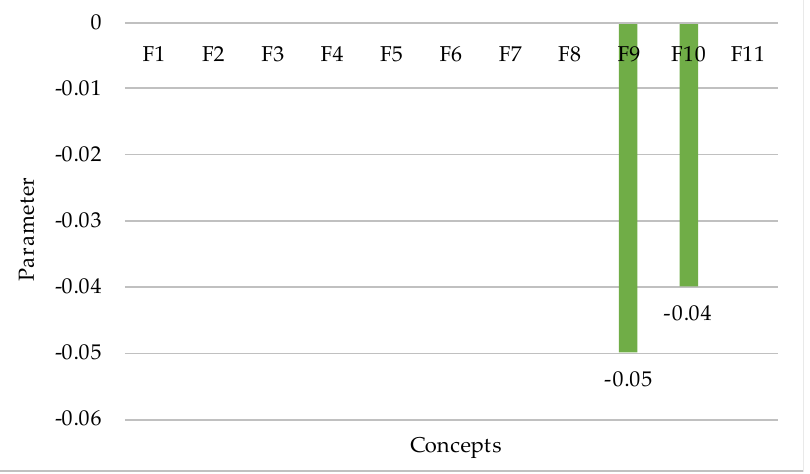
Figure 2. Scenario demonstrating the system response to the most negative changes in the concept 3F —malware.